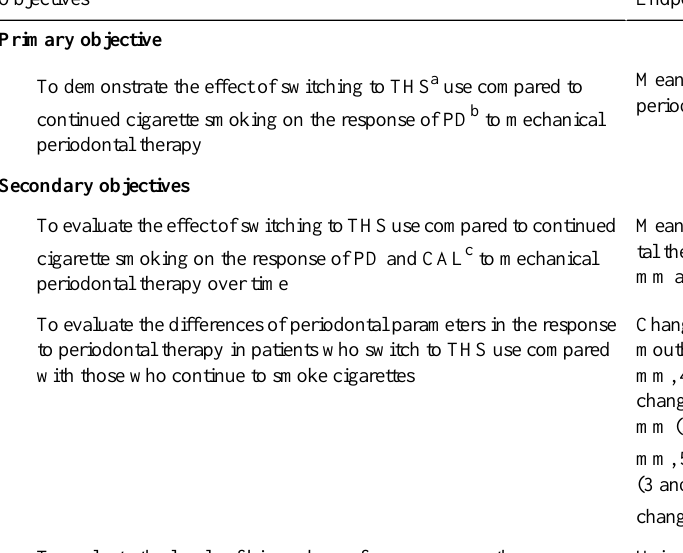
Table 1. Objectives and endpoints of the